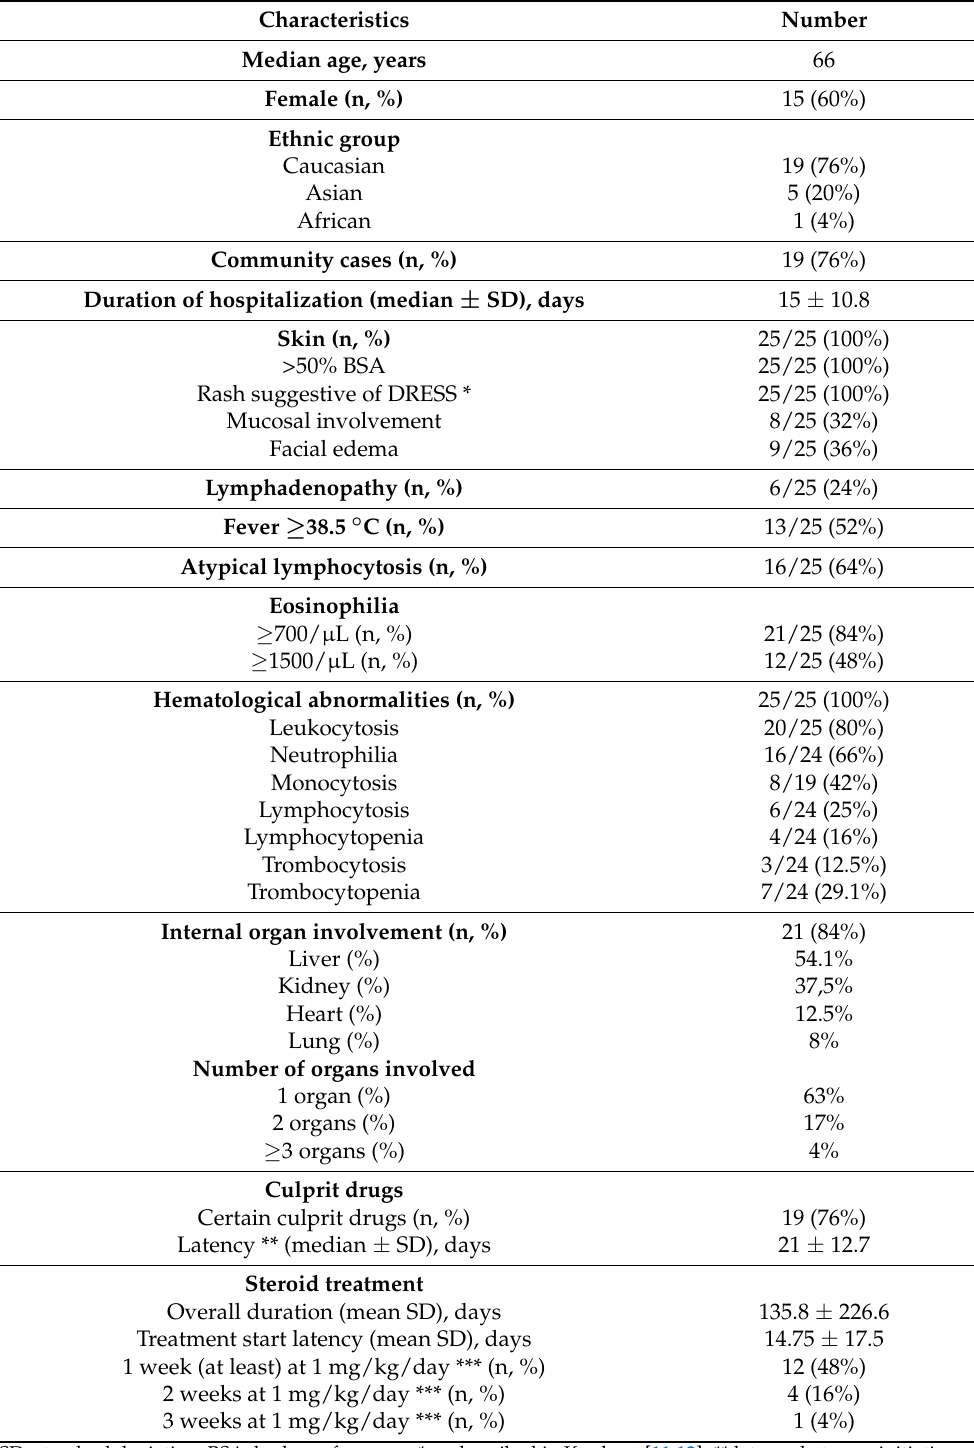
Table 1. Characteristics of 25 patients with DRESS